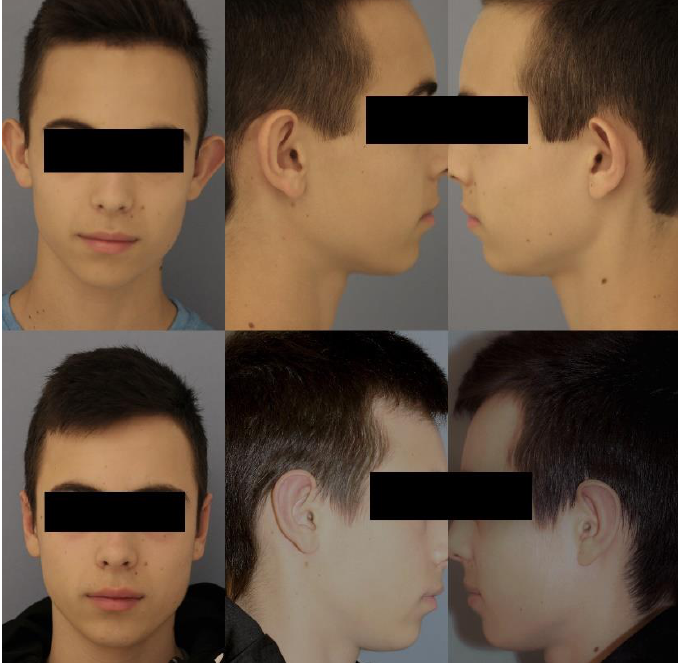
Figure 5. Fifteen-year-old patient with bilateral asymmetrical ear protrusion; the left antihelix shows greater deficiency compared to the right (anterior view, lateral view). The same patient after ventral otoplasty according to Lemperle’s technique; the left antihelix shows greater folding to reach more symmetry. Scars are hidden in the scapha and cannot be seen without manipulation (anterior view, lateral view).